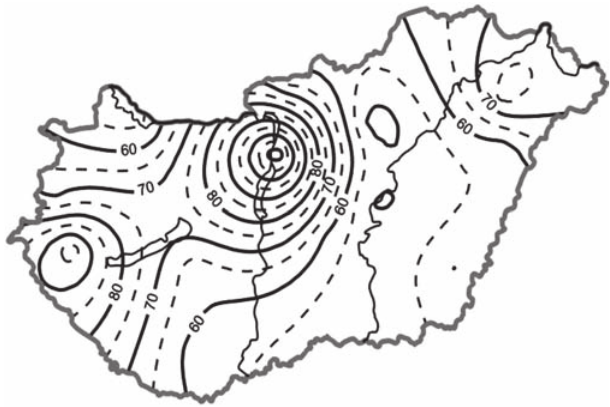
Figure 3 – The absolute daily maxima of precipitation in autumn over 16 meteorological stations during the period of 1951–2010